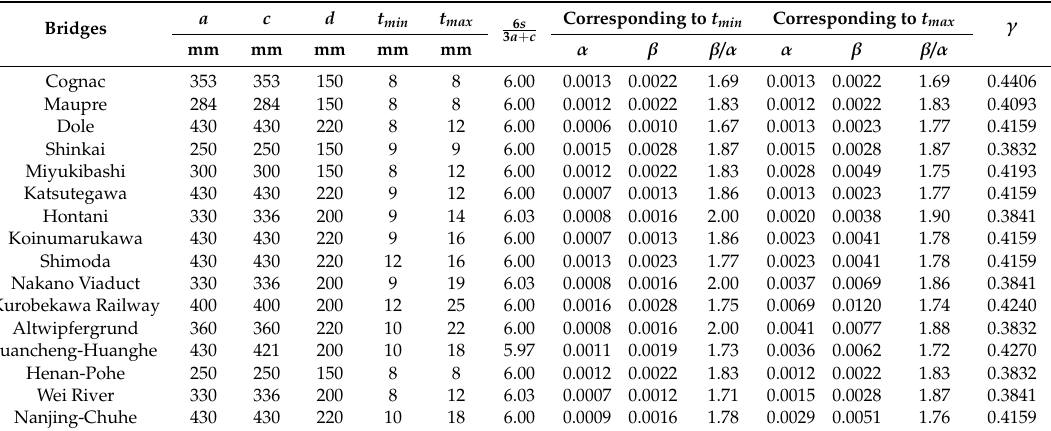
Table 1. The geometry of CSWs in available